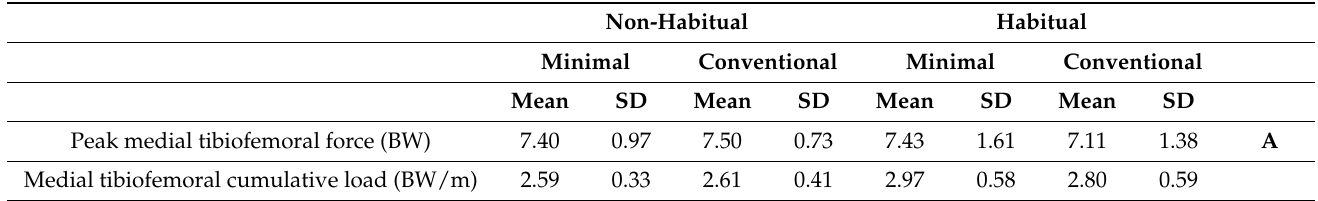
Table 4. Joint contact force